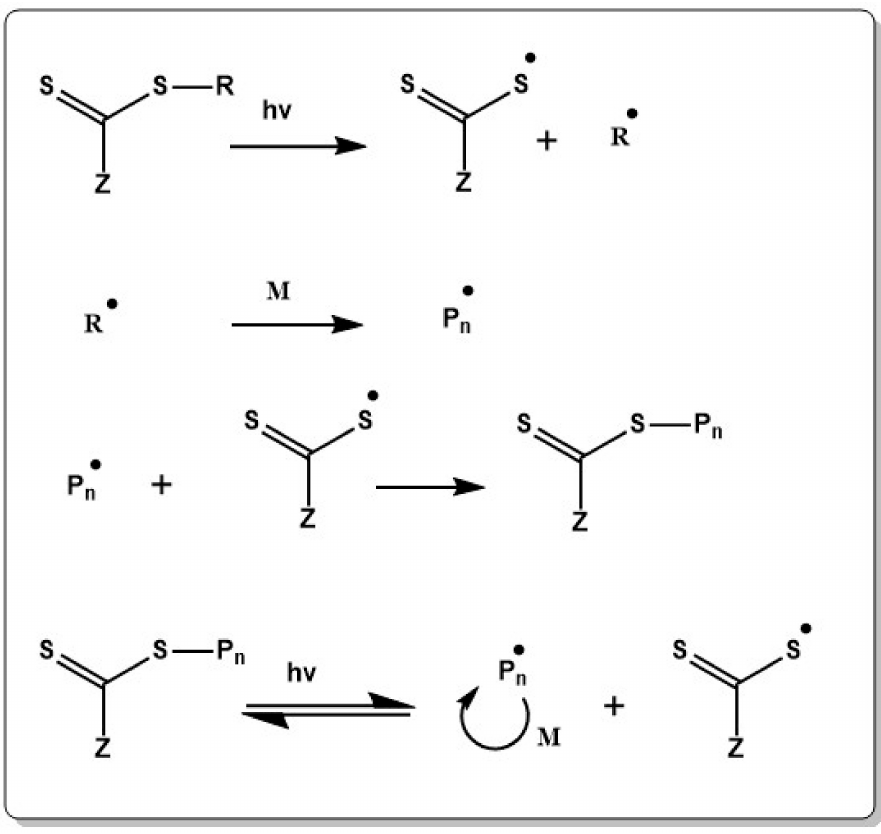
Scheme 9. Reaction mechanism for photo-RAFT involving iniferter